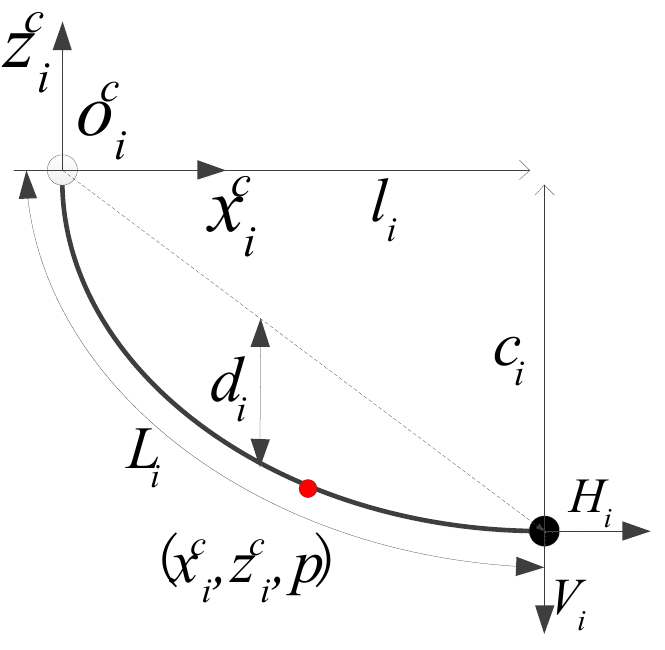
components of the cable tension at the terminal point of the cable; l i and c i are the horizontal and vertical spans of the catenary cable, respectively.